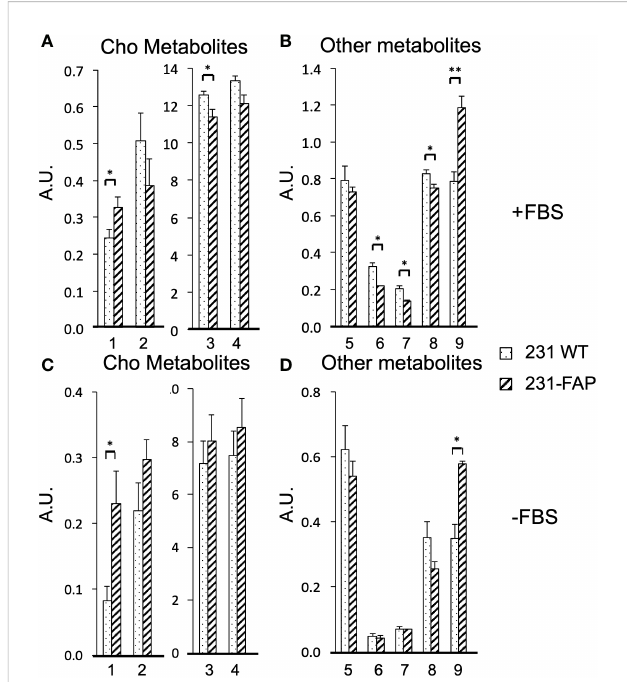
FIGURE 3 Relative concentrations in arbitrary units (A.U.) of (A) choline metabolites (1: Cho, 2: GPC, 3: PC, 4: total choline (tCho = Cho + PC + GPC) and (B) other metabolites (5: GSH, 6: Cr and PCr, 7: Cr, 8: Tau, 9: MI) from 231 WT and 231-FAP cells with FBS. (C) Choline metabolites and (D) other metabolites from 231 WT and 231-FAP cells